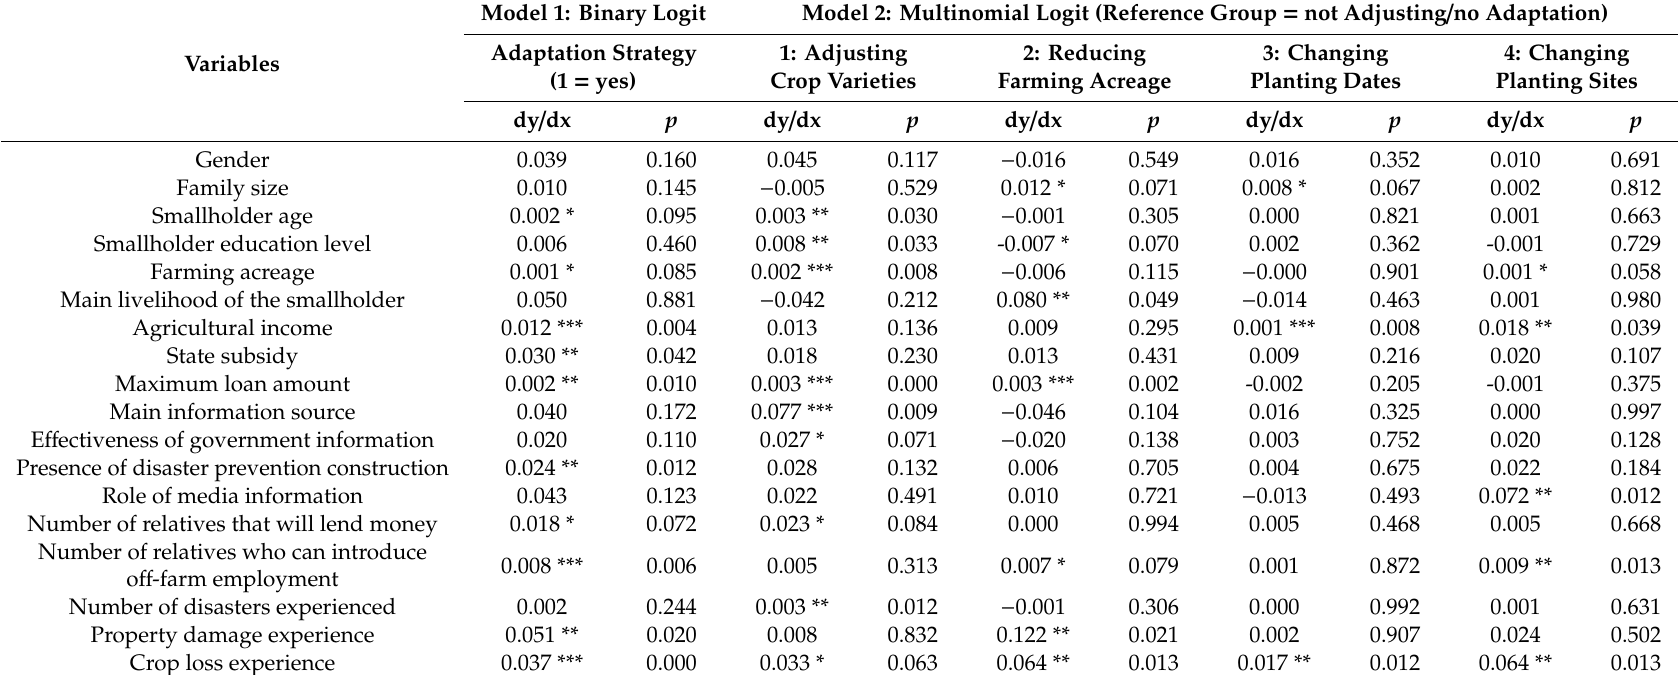
Table 3. Marginal e ff ects on the determinants of adaptation